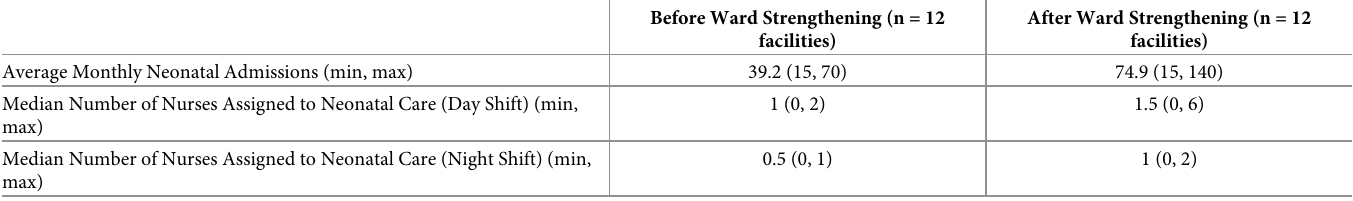
Table 5. Comparison of ward assessments for average monthly admissions and nurse allocations before and after ward-strengthening program at district-level hos- pitals in Malawi (2017–2018).